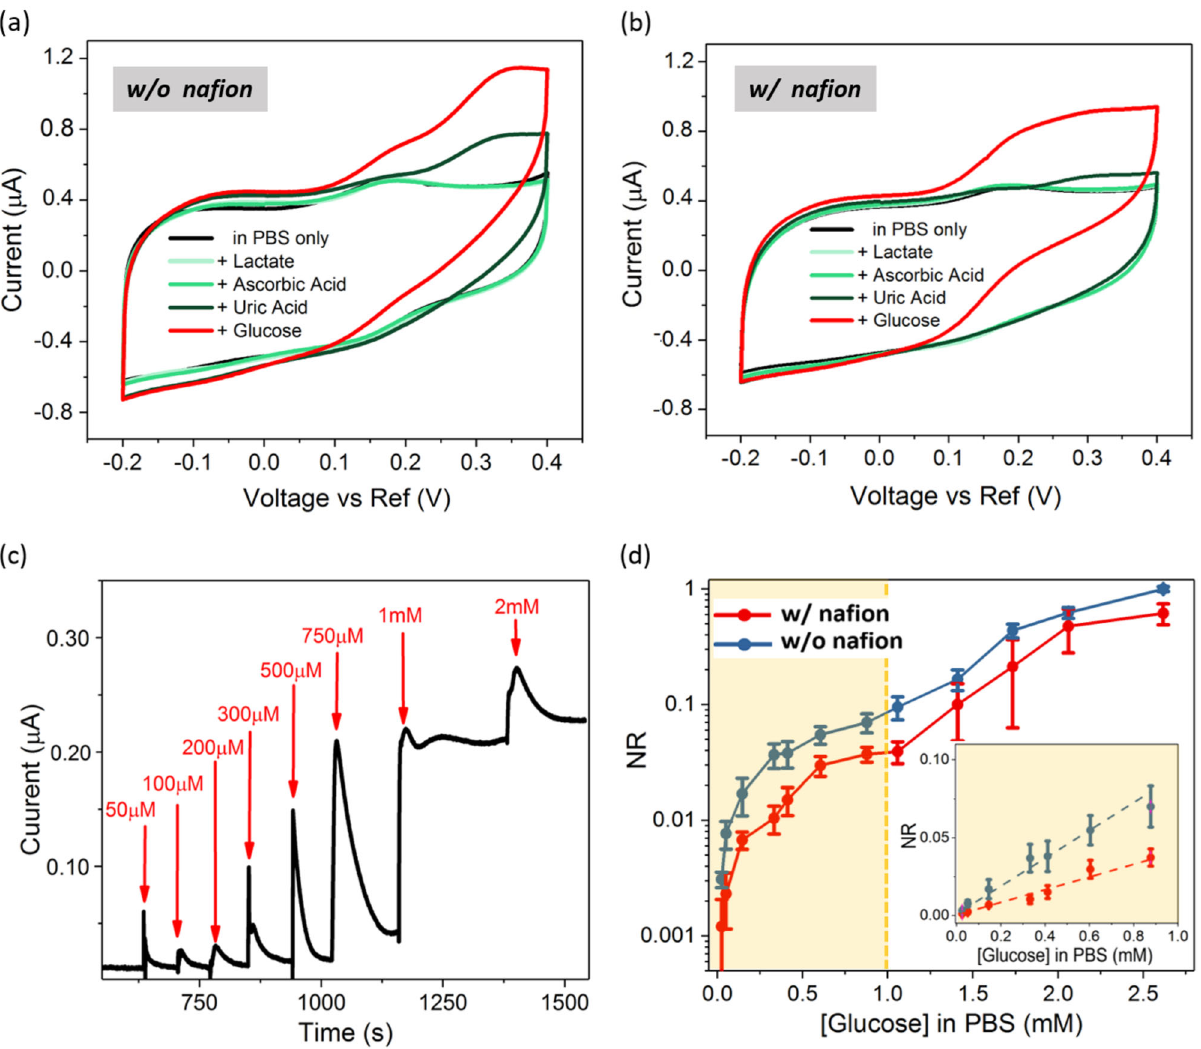
Fig. 3 CV curves of a printed sensor a without and b with na fi on encapsulation (2 printed layers) in the presence of various chemical species in PBS solution. In the interference tests, the concentrations of these compounds in PBS are 2 mM for lactate, 0.01 mM for ascorbic acid, and 0.15 mM for uric acid while glucose concentration is 1 mM. Note that the compounds were added successively to the solution, from lactate to glucose. c Current-time characteristics of the sensor in response to different concentrations of glucose added successively into the measurement solution (PBS). The arrows highlight the times at which glucose was introduced into PBS. The applied voltage is 0.25 V versus PEDOT:PSS reference electrode. d Normalized response (NR) of the sensor to glucose in PBS with (red curve) and without na fi on (blue curve). The inset is the magni fi ed calibration curve in linear scale. Data represent average read-outs from three different